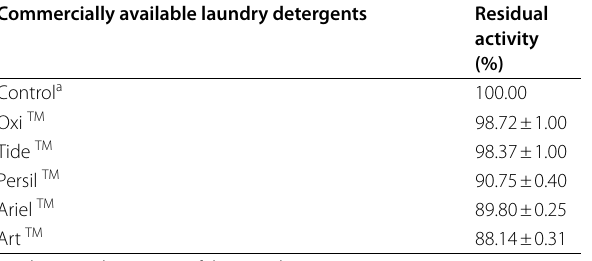
Table 2 b : Stability of Pull_Met in presence of commercially available laundry detergents Commercially available laundry detergents